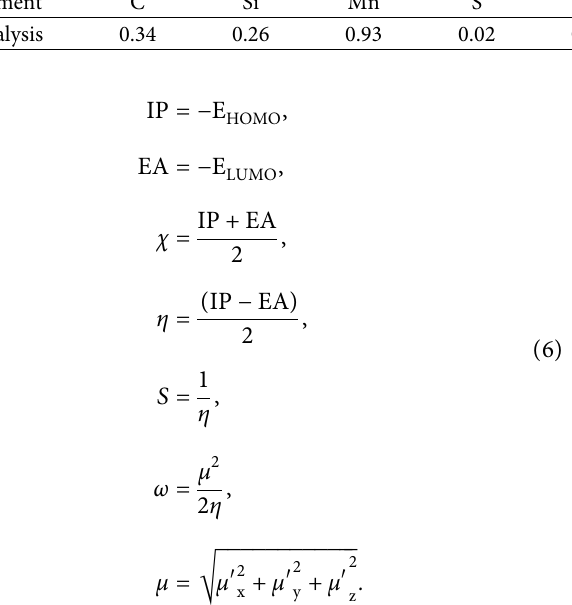
Table 1: Te chemical composition (weight %) of the mild steel electrode.